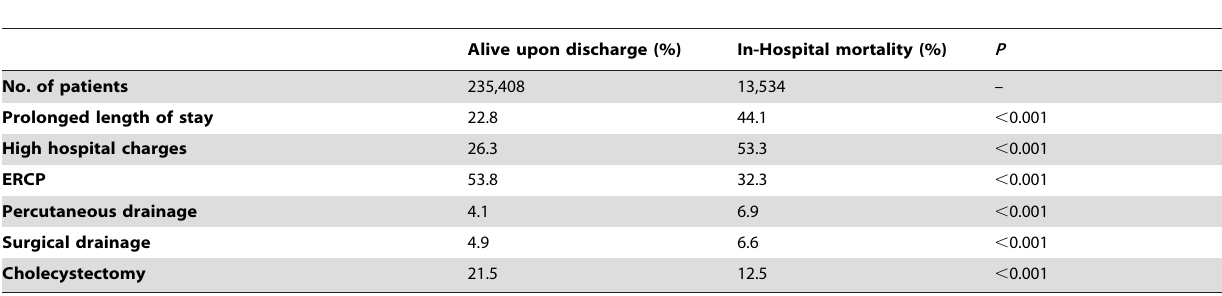
Table 1. Weighted outcomes and interventions during hospitalization according to mortality.